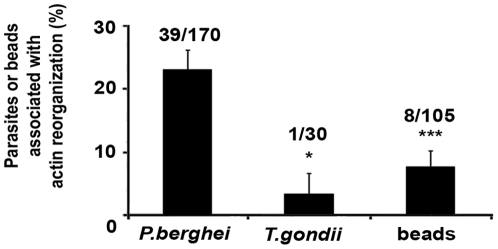
Hepatocyte cytoskeleton reorganization depends on the presence of P. berghei.Percentage of parasites (P. berghei and T. gondii) and beads associated with hepatocyte actin reorganization between 10 and 16 hours p.i. or bead internalization. Numbers of parasites or beads associated with actin reorganization/total numbers of parasites or beads analysed are indicated above the bars. Error bars represent Standard Errors * p<0.05 *** p≤0.001.